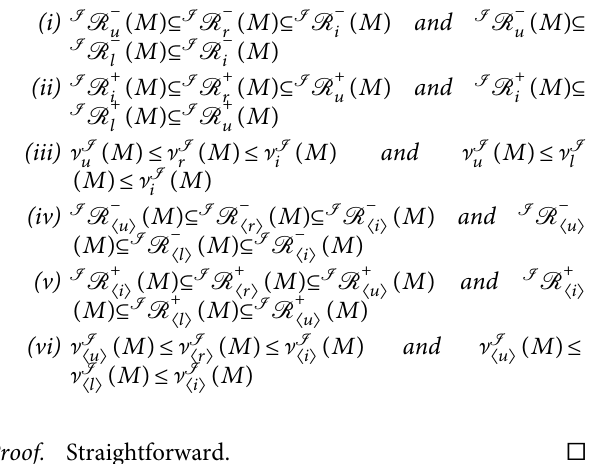
j -accuracy measures for